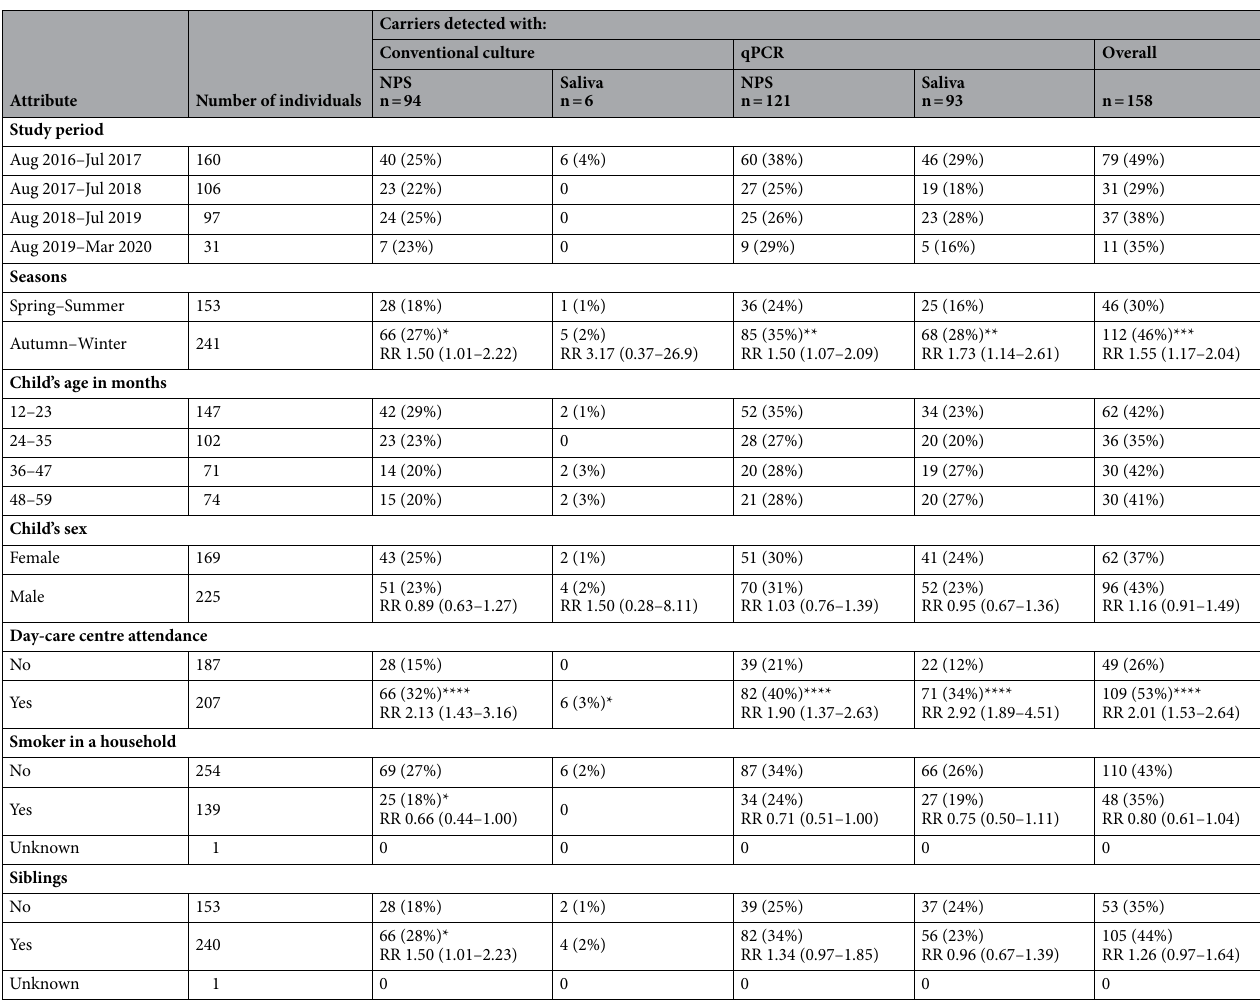
Table 1. Effect of study period, child’s age, sex and environmental factors on S. pneumoniae carriage detected using culture and qPCR-based method. p —* < 0.05, ** < 0.01, *** < 0.001, and **** <